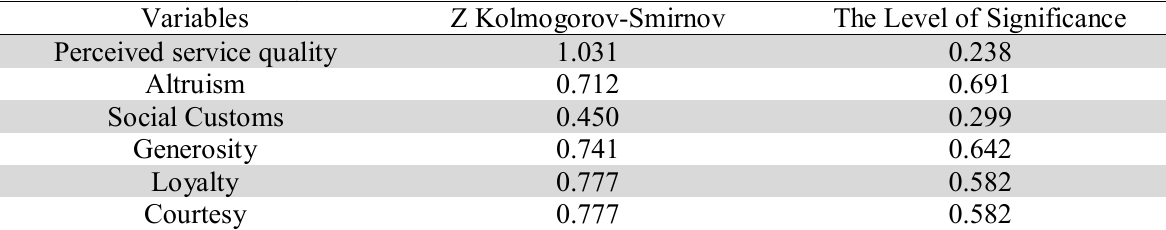
The summary of Kolmogorov-Smirnov